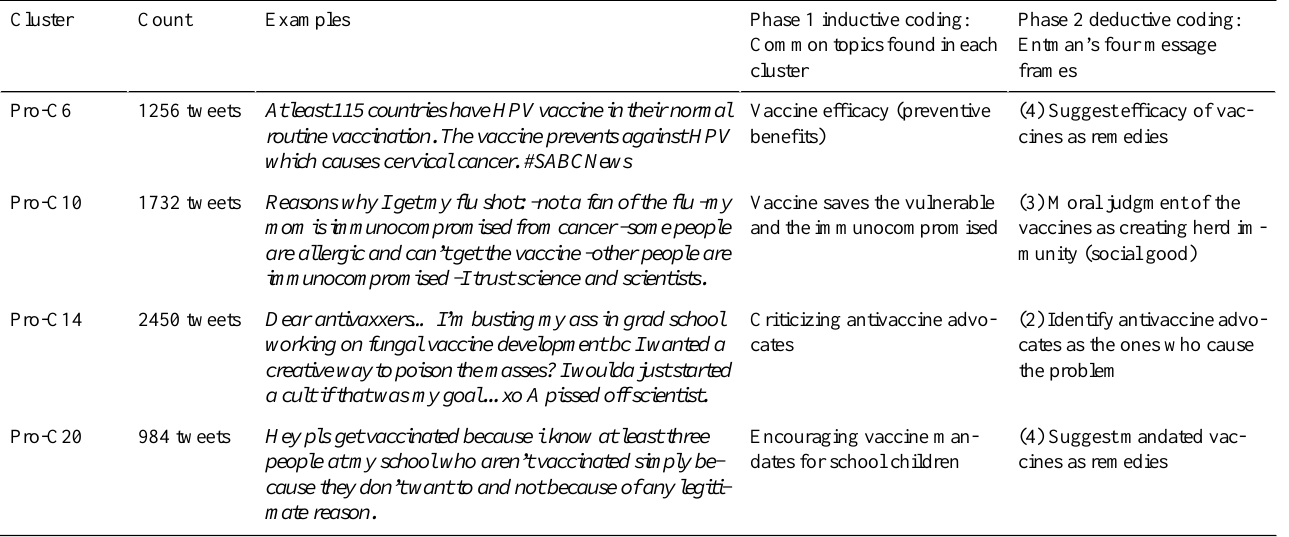
Table 5. Message frames used in prominent provaccine clusters.